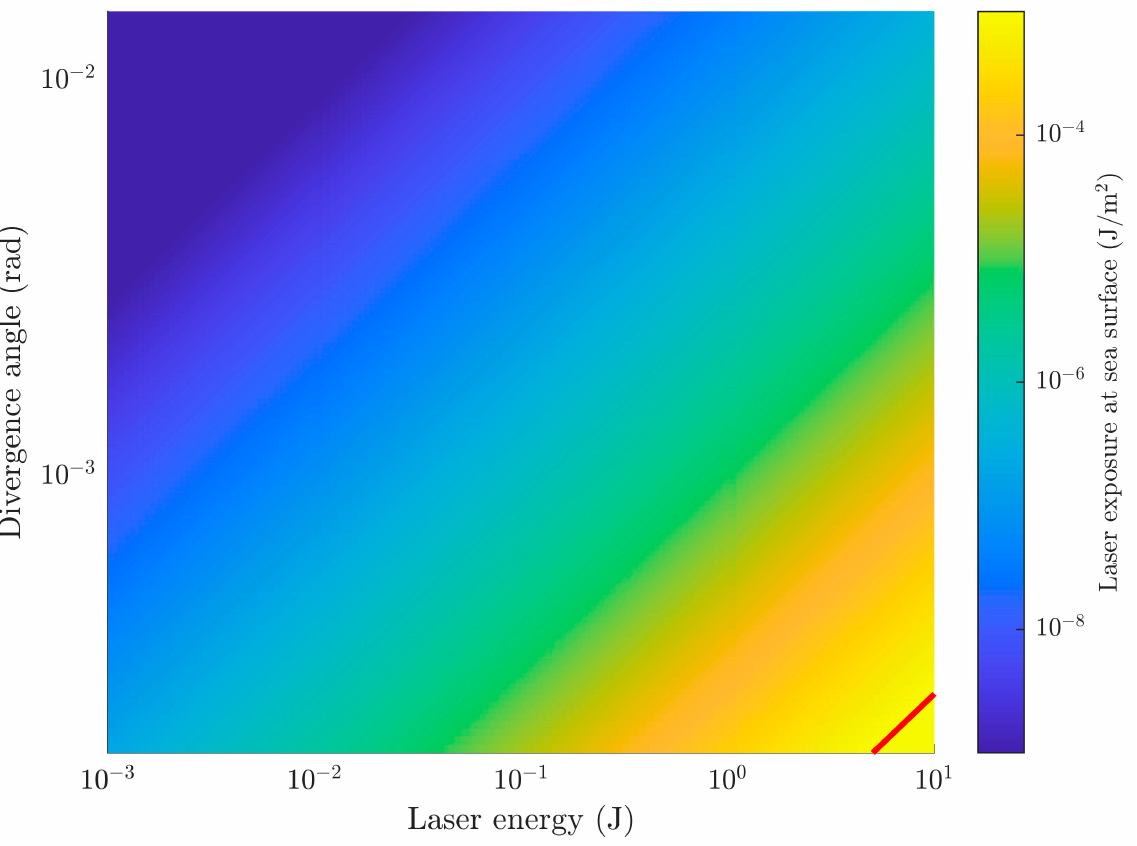
Figure 20. Laser exposure at the sea surface versus the laser energy and divergence angle. The redline is the single-pulse exposure limit.